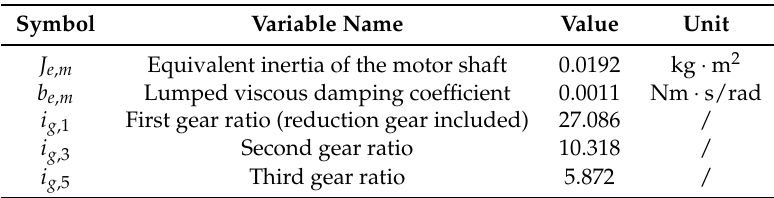
Table 1. Main parameters used in controller design.